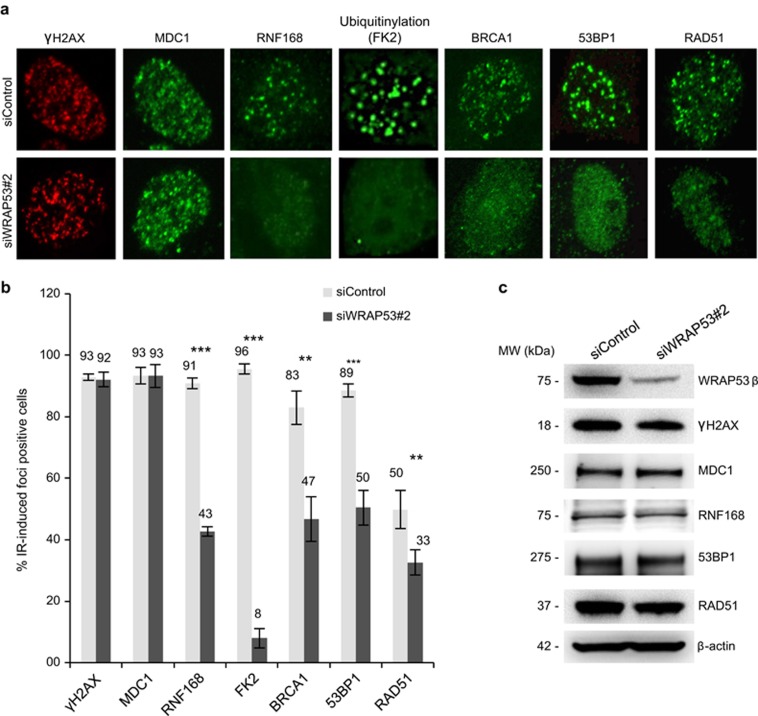
WRAP53β plays an important role in recruitment of factors involved in HR and NHEJ to DNA breaks in A2780 cells. (a) A2780 cells were transfected with siControl or siWRAP53#2 oligonucleotides for 48 h; exposed to IR (6 Gy), and 1 h later immunostained for γH2AX, MDC1, RNF168, FK2 (recognizes conjugated ubiquitin), BRCA1, 53BP1 and RAD51. (b) Quantification of the results in (a), as the percentage of 200 cells counted in each experiment whose nuclei contained >10 IR-induced foci. The error bars depict the S.E.M.; n=3, **P<0.01 and ***P<0.001, as determined by Student's t-test. (c) A2780 cells were treated as in (a) and then subjected to western blotting for WRAP53β, γH2AX, MDC1, RNF168, 53BP1, RAD51 and β-actin. We could not assess the protein levels of BRCA1 due to a lack of antibodies that work for western blotting